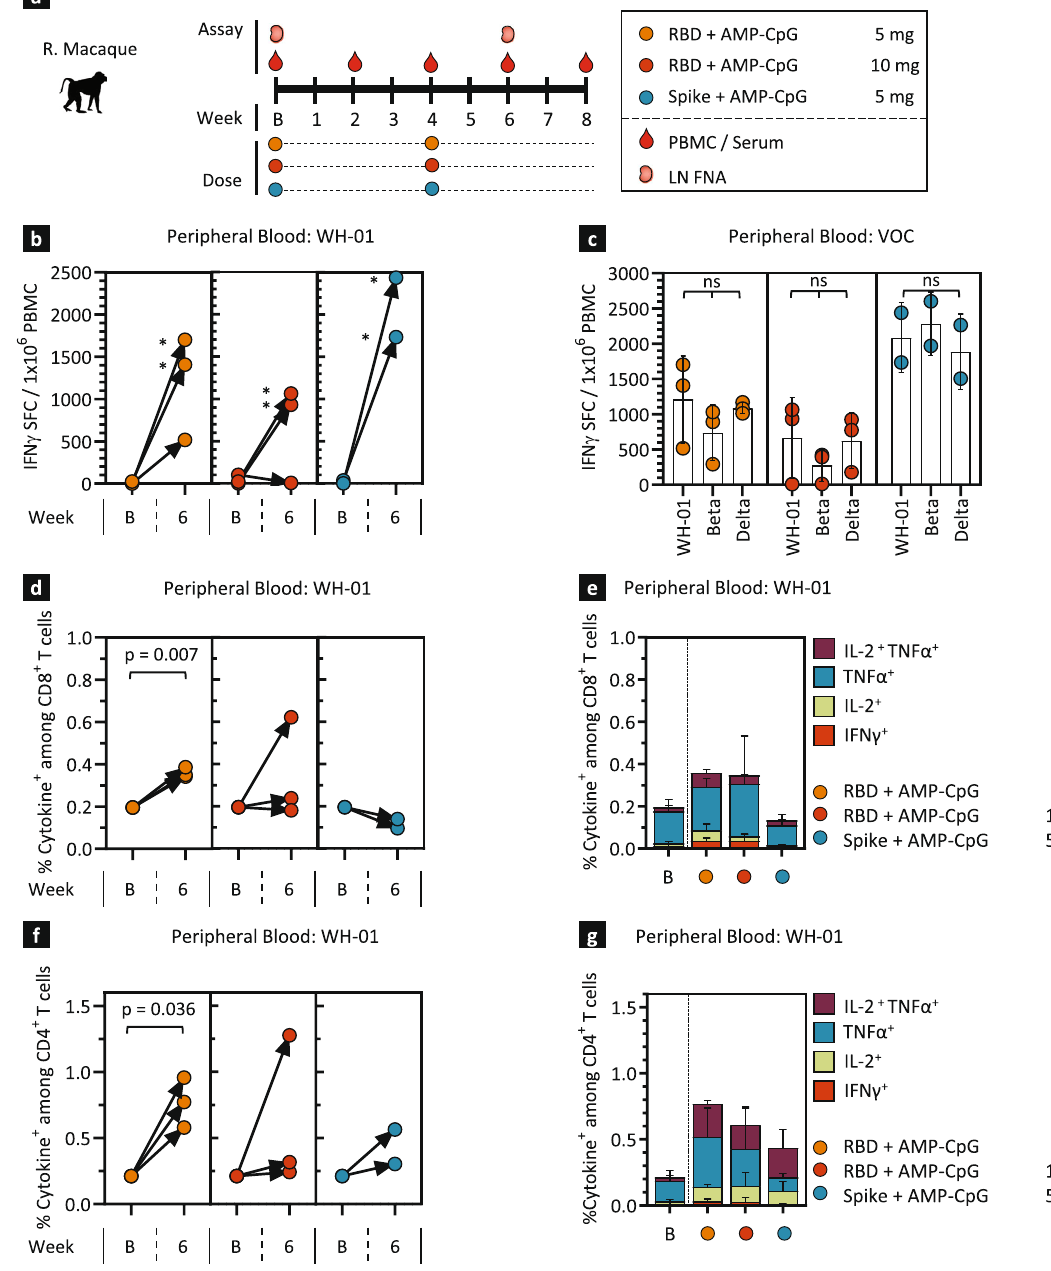
Fig. 5 AMP-CpG immunization induces robust T cell responses to multiple variants of SARS-CoV-2 in NHPs. Rhesus macaques ( n = 2/3) were immunized at week 0 and 4 with 140 µg WH-01 RBD protein admixed with either 5 mg or 10 mg of AMP-CpG, or 140 µg full WH-01 Spike protein admixed with AMP-CpG at 5 mg. PBMCs were collected at baseline and week 6 for T cell response assessment. a Schema showing animal dosing and experimental schedule. b , c PBMCs were stimulated at 0 and 6 weeks with WH-01 RBD OLPs or with VOC OLPs at 6 weeks prior to analysis by IFN γ ELISpot assay. Shown are IFN γ SFCs per 1 × 10 6 PBMCs. d – g PBMCs were stimulated with WH-01 OLPs prior to analysis for intracellular cytokines by fl ow cytometry. Shown are frequencies of total ( d , f ) and individual IL-2, TNF α , IFN γ cytokine producing ( e , g ) CD8 + ( d , e ) and CD4 + T cells ( f , g ). Values depicted are mean ± standard deviation. *p < 0.05 by two-sided Mann-Whitney test ( b , d , f ), or paired one-way ANOVA followed by Tukey ’ s ( c ) or Dunnett ’ s ( e , g ) post-hoc analysis applied to cytokine + T cell frequencies. LN lymph node, B REF. 43 ). This was consistent with a lack of IFN β and interferon- the immunomodulatory potential of TLR-9 agonism to coordinate innate and adaptive immunity. induced transcripts observed in lymph nodes following soluble TLR-9 engagement by type B CpG DNA (including CpG-7909) is CpG vaccination in mice. However, in the case of AMP-CpG, IFN β predominantly thought to induce maturation of B cells and and interferon-induced transcripts were notably elevated 24 h plasmacytoid DCs with lesser ability to promote production of after vaccination in mice and NHPs. Further, the development of Type I interferons relative to other CpG subclasses (reviewed in the lymph node in fl ammatory proteomic milieu was almost fully